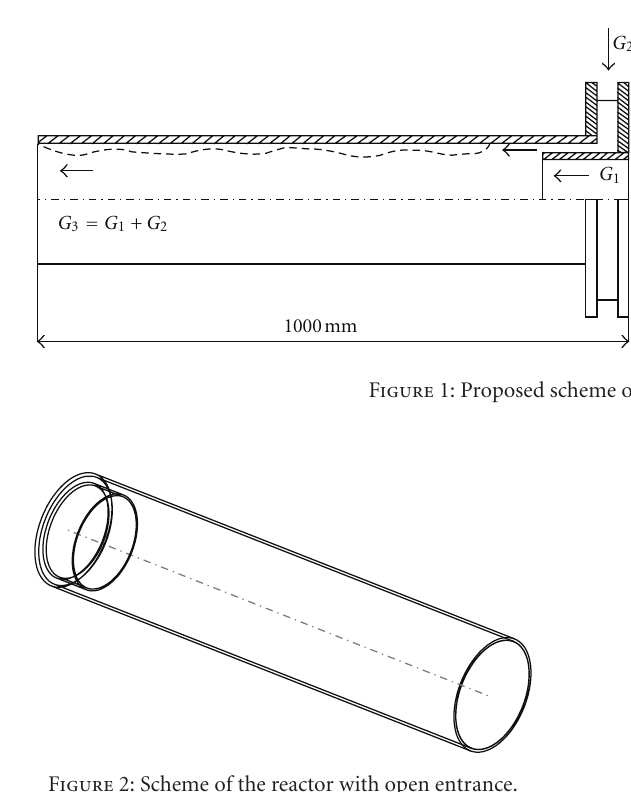
Figure 2: Scheme of the reactor with open entrance.